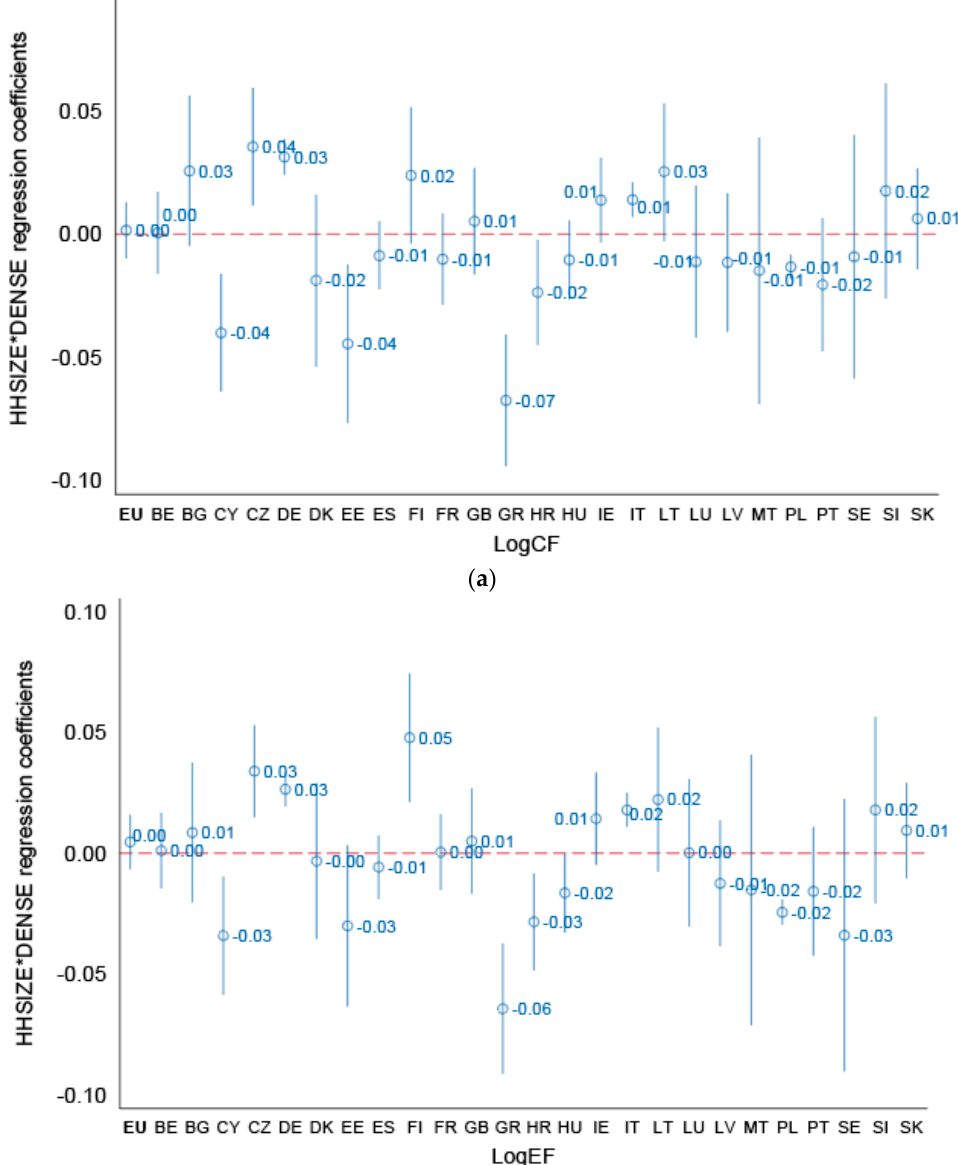
Figure 8. Interaction effect between household size and population density ( HHSIZE×DENSE ) across countries. Dependent variables—the log of per capita carbon ( a ) and energy ( b ) footprints. We excluded the HHSIZE×INTERMEDIATE interaction term as no significant differences of the household size effects between intermediately and sparsely populated areas were noted. See Data and Methods for the model specification. Household weights provided by the HBS have been applied.